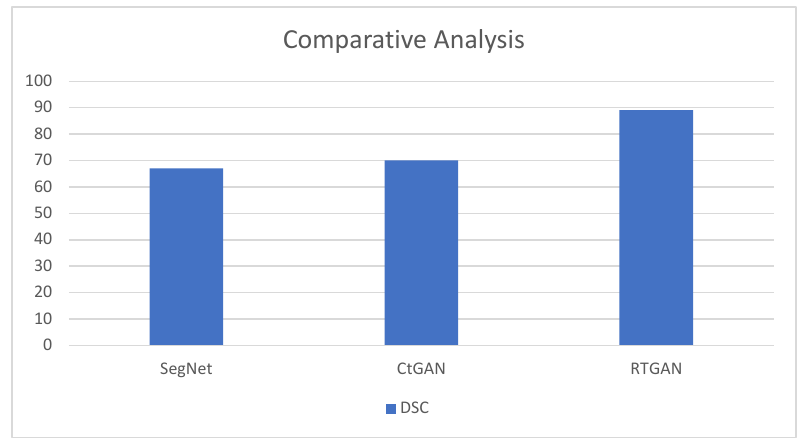
Figure 11. Comparative Analysis of Proposed Work with Previous Models.